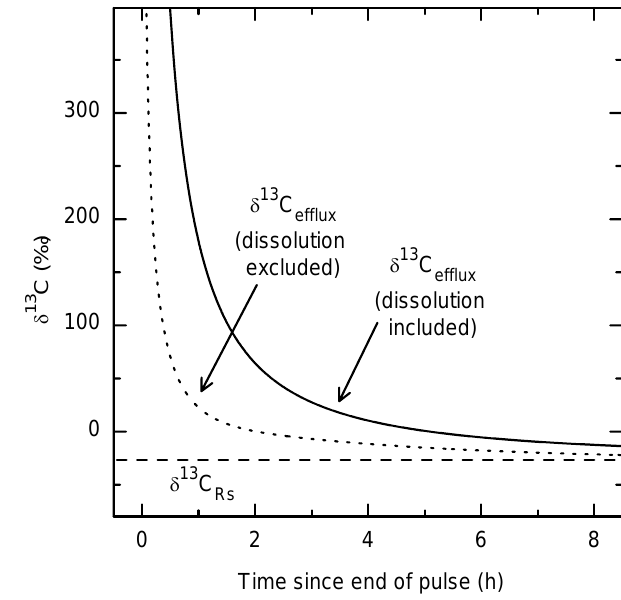
Fig. 8. Modelled re-equilibration time, the time interval between a step change in δ 13 C atm from labelling ( − 46 . 9‰) to ambient ( − 8 . 5‰) conditions and δ 13 C efflux reaching δ 13 C Rs within 0.4‰ (corresponding to 1% of the difference between ambient and la- belled CO 2 ). Simulations included dissolution for various pH val- ues (closed squares) or excluded dissolution (dashed line).